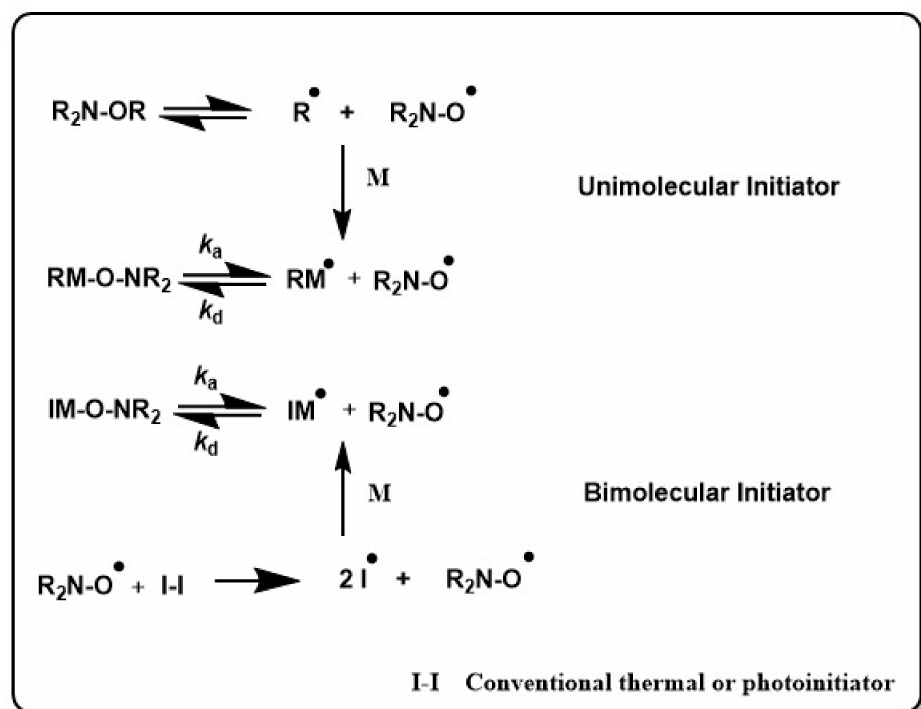
Scheme 3. Initiation mechanism of uni- and bimolecular initiators in